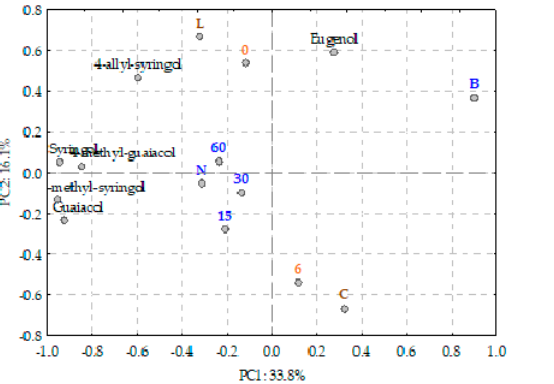
Figure 3. PCA was performed with spectral information of the AWS with chestnut (C) and with Limousin wood, acquired in NIR. Legend: C and L stand for the wood used in the ageing process, Chestnut and Limousin respectively; 15, 30 and 60 the different levels of micro-oxygenation used in the alternative system; N—no micro-oxygenation used in the alternative system; B—Barrel; 0—0 months in a bottle; 6—6 months in bottle.